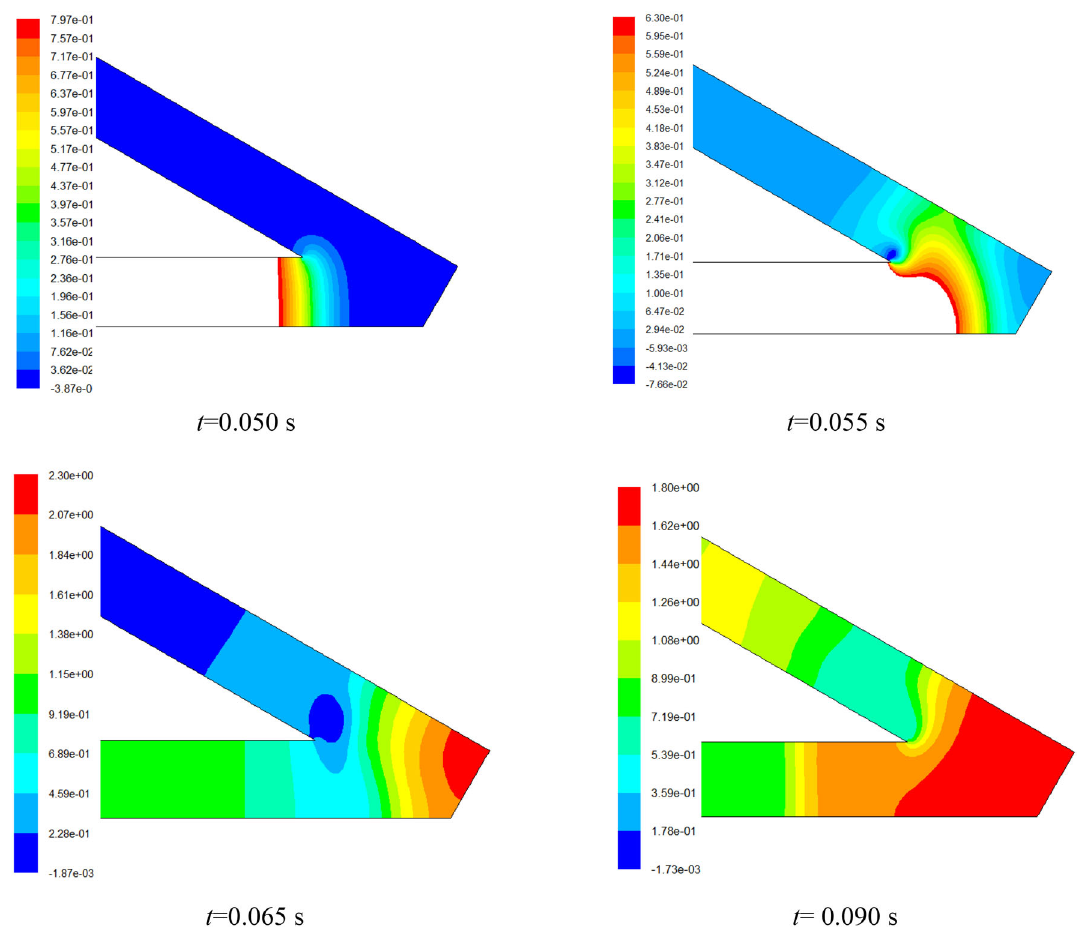
Fig. 6 Contour plots of outburst shock wave overpressure with